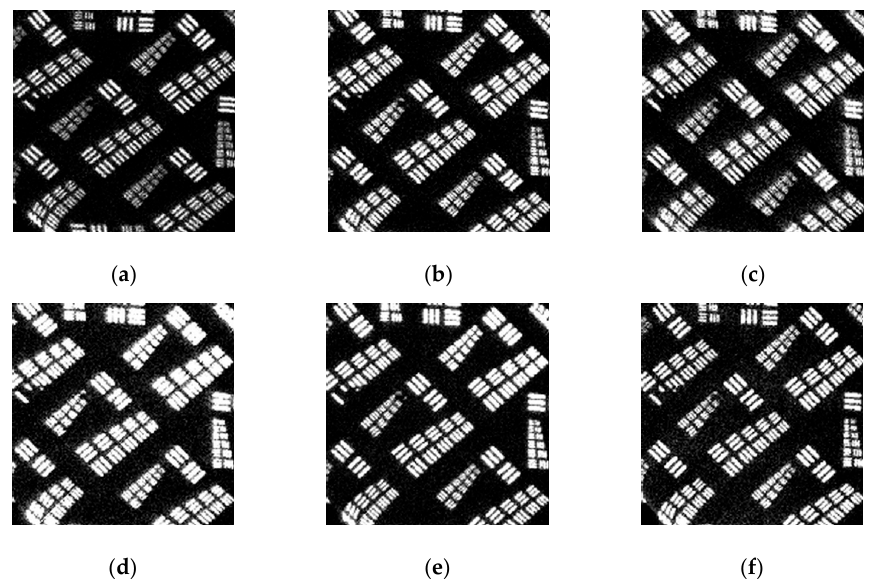
Figure 16. Imaging of the resolution mask with different incident intensities ( I in ) and peaking times for the pulse shaper ( T p ). The edges of the images are slightly distorted due to the mutual capacitance between anode electrodes: ( a ) I in = 100 kcps, T p = 500 ns; ( b ) I in = 200 kcps, T p = 500 ns; ( c ) I in = 300 kcps, T p = 500 ns; ( d ) I in = 400 kcps, T p = 500 ns; ( e ) I in = 400 kcps, T p = 200 ns; ( f ) I in = 400 kcps, T p = 100 Figure 17 plots the resolution versus the incident photon counting rate, showing data taken at different pulse shaper peaking times. For an incident photon counting rate of 50 kcps, there is no